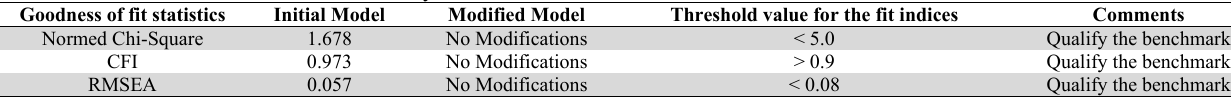
The results of statistical tests for MM